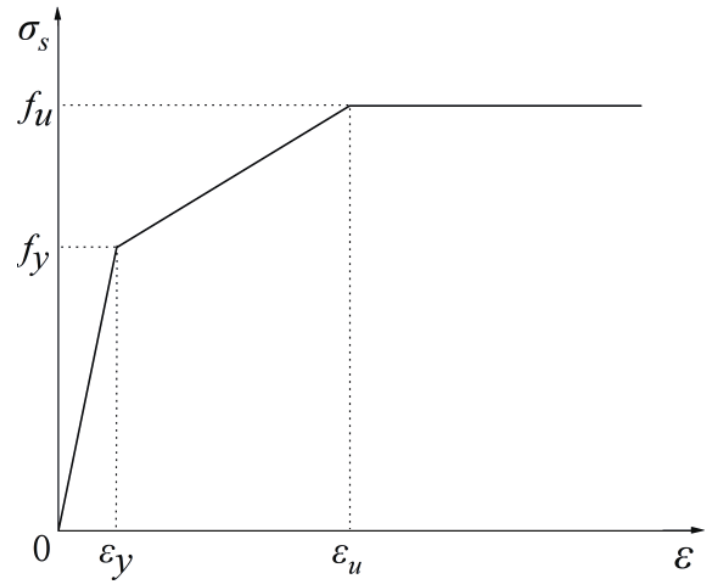
Figure 10. Stud stress–strain relationship